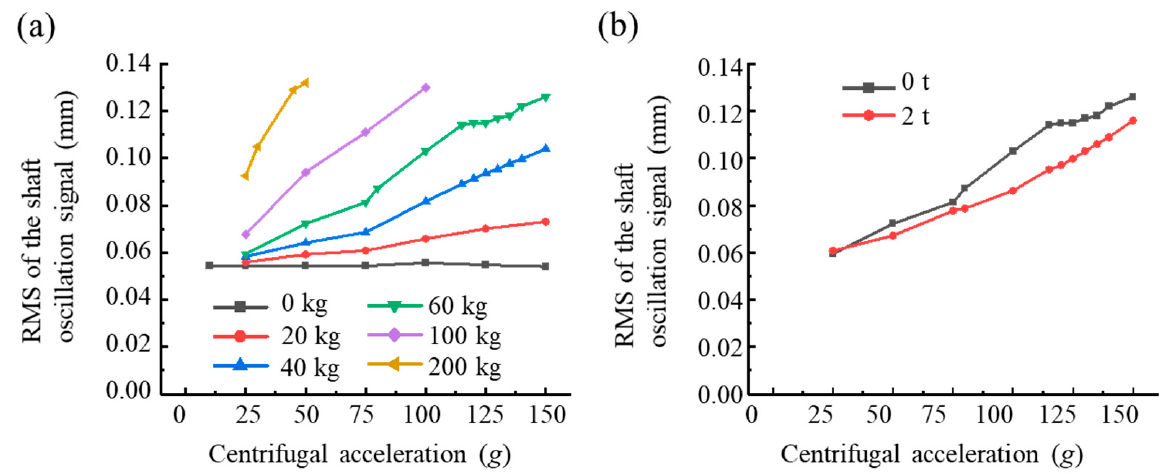
Figure 7. Effects of centrifugal acceleration on the RMS of shaft oscillation. ( a ) RMS of the shaft oscillation at different added unbalanced masses (0 t operating load). ( b ) RMS of the shaft oscillation at 0 t and 2 t operating loads (60 kg added unbalanced mass).